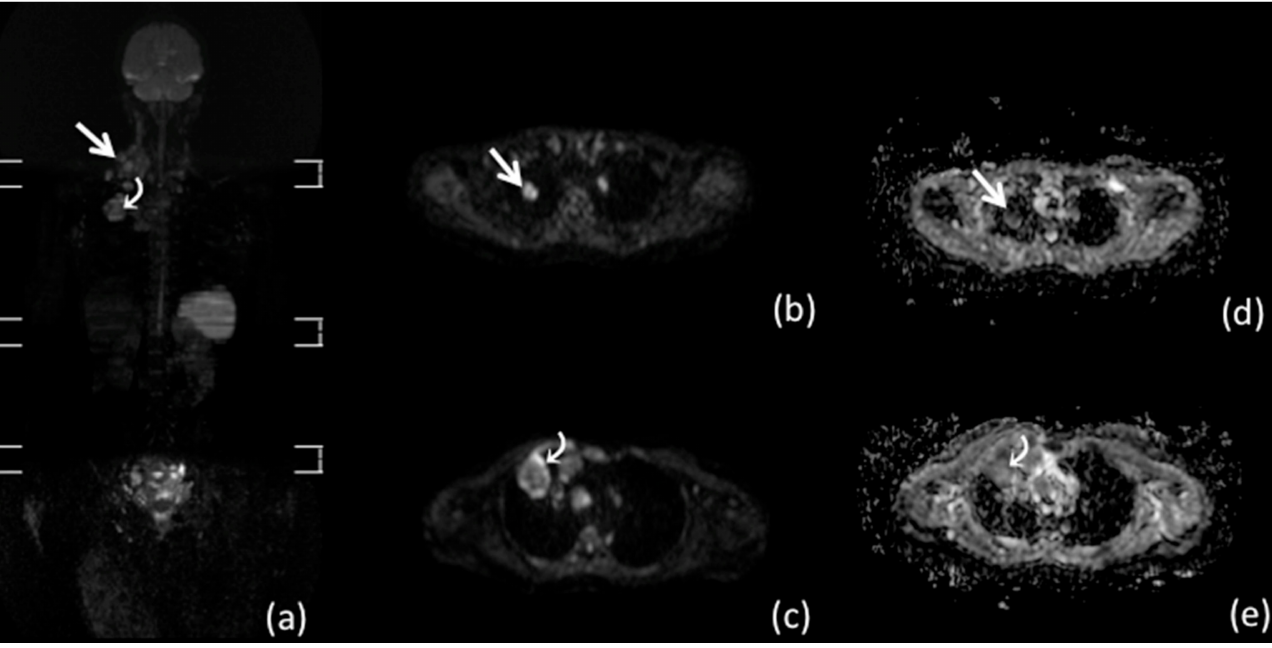
Figure 1. Whole-body MRI of a 28-year-old man with Hodgkin Lymphoma. Coronal maximum intensity projection (MIP) b = 800 diffusion-weighted imaging (DWI) ( a ), axial b 800 DWI images of the chest ( b , c ), and axial ADC maps of the chest ( d , e ), show a lung location in the apical segment of the upper lobe of the right lung (curved arrow in ( a ); arrow in ( b , d )) and multiple nodal locations at internal mammary level (arrow in ( a ); curved arrow in ( c , e